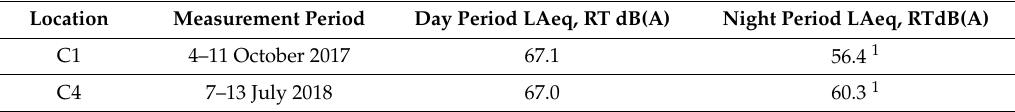
Table 5. The noise levels in different seasons on the same road-arch in Livorno.